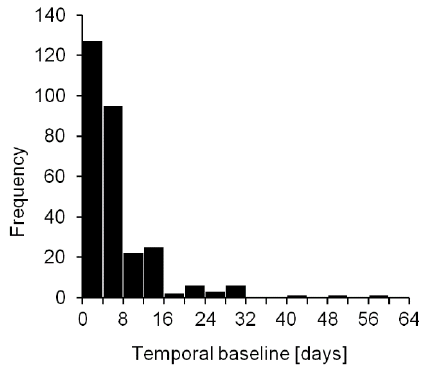
Figure 2. Histogram of the temporal baselines of the COSMO-SkyMed data stack acquired in StripMap HIMAGE mode over Wuhan between 2011 and 2020.